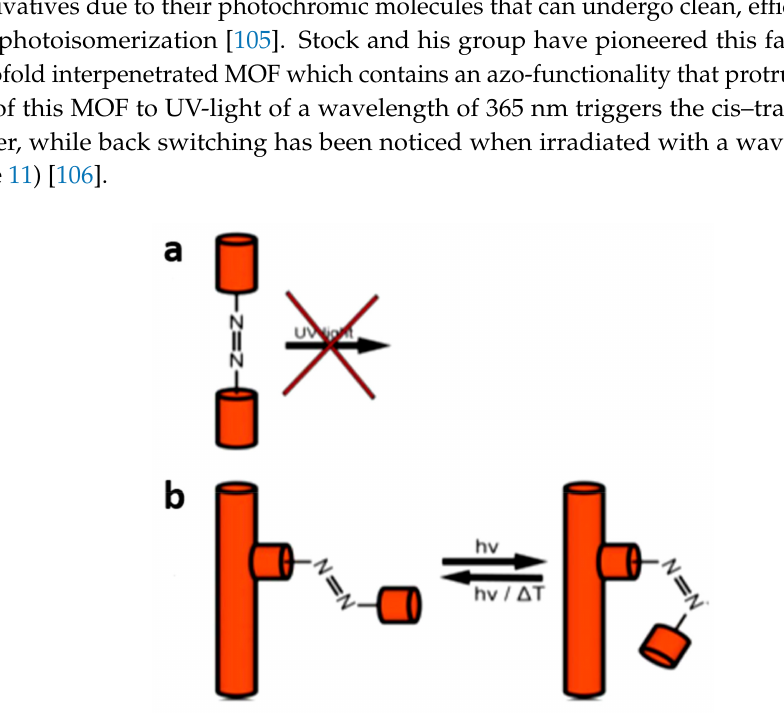
Figure 11. Photo-switchable azobenzene side groups. ( a ) Azo-linker as part of the backbone of the MOF, ( b ) azo-group covalently attached to the inner pore wall and extended into the pore